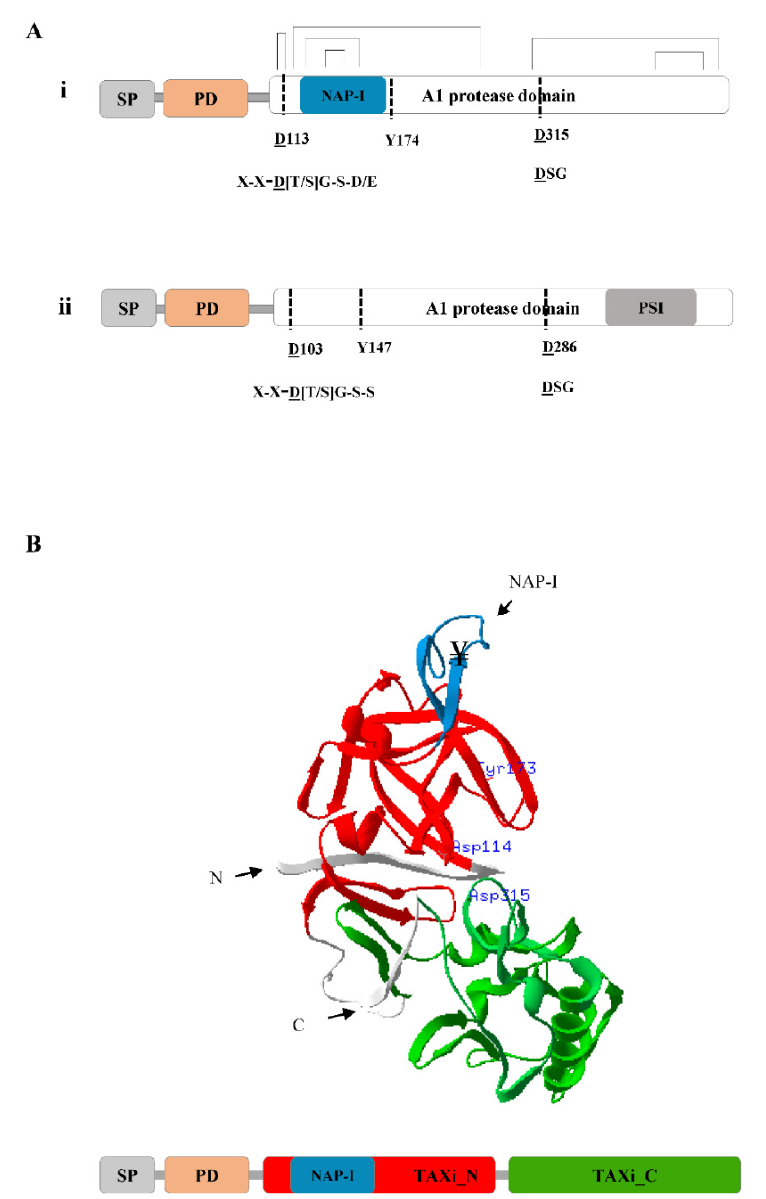
Figure 1. Schematic representation of the structure of nepenthesins (NEPs) and phytepsins (PEPs). ( A ) The primary structure organization of N . gracilis nepenthesin-2 (MER0031641) (i) and Cynara cardunculus phytepsin (MER0004937) (ii). Both proteins contain a signal peptide (SP), a prodomain (PD) and the A1 protease domain. The protease domain contains the two catalytic Asp residues (underlined) and the “flap” Tyr residue. The position of the PSI and NAP-I sequences are indicated for phytepsin and nepenthesin, respectively. The PEP and NEP signature motifs that contain the two catalytic Asp residues are indicated corresponding to the two Asp residues for both phytepsin and nepenthesin, (Ø- hydrophobic residue, D- Asp, T-Thr, G- Gly, Ser, E-Glu; [31]). ( B ) The tertiary structure of N . gracilis nepenthesin-2 protein predicted using Swiss PDB viewer [34]. The 3D annotation is based on the HMM based profile scan of the primary structure (shown below). In the primary structure, the position of the SP, PD, TAXi_N and TAXi_C, NAP-I sequence, and structurally important six disulfide bridges are shown. Two of the disulfide bridges are located in the NAP-I sequence. The TAXi_N and TAXi_C domains and the NAP-I sequence are colored in the 3D structure, consistent to the primary structure. The N- and C- termini and the active site residues (D113 Y174 D315) of the protein are also shown.